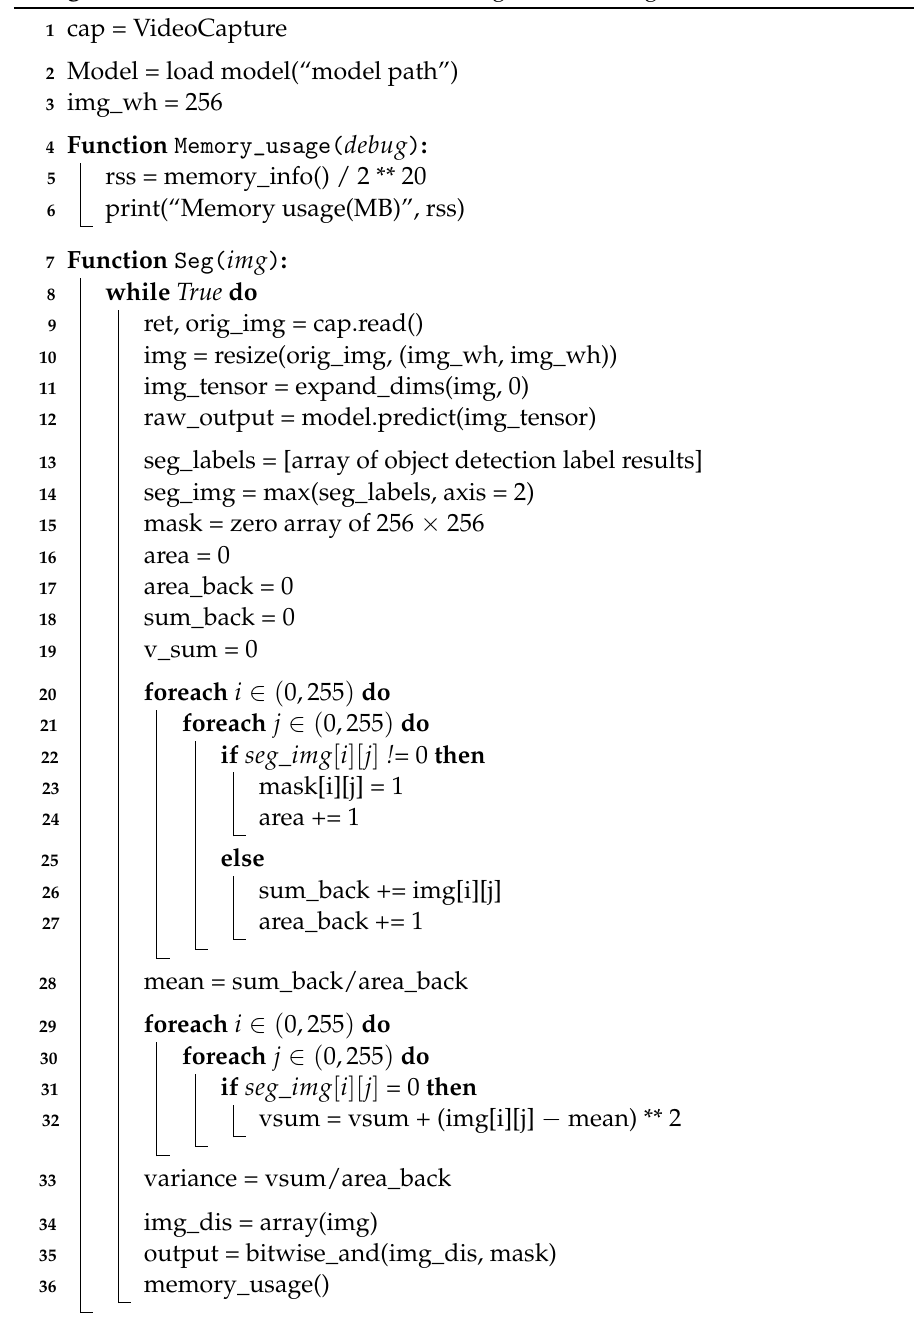
Algorithm 1: Pseudo-code of semantic segmentation